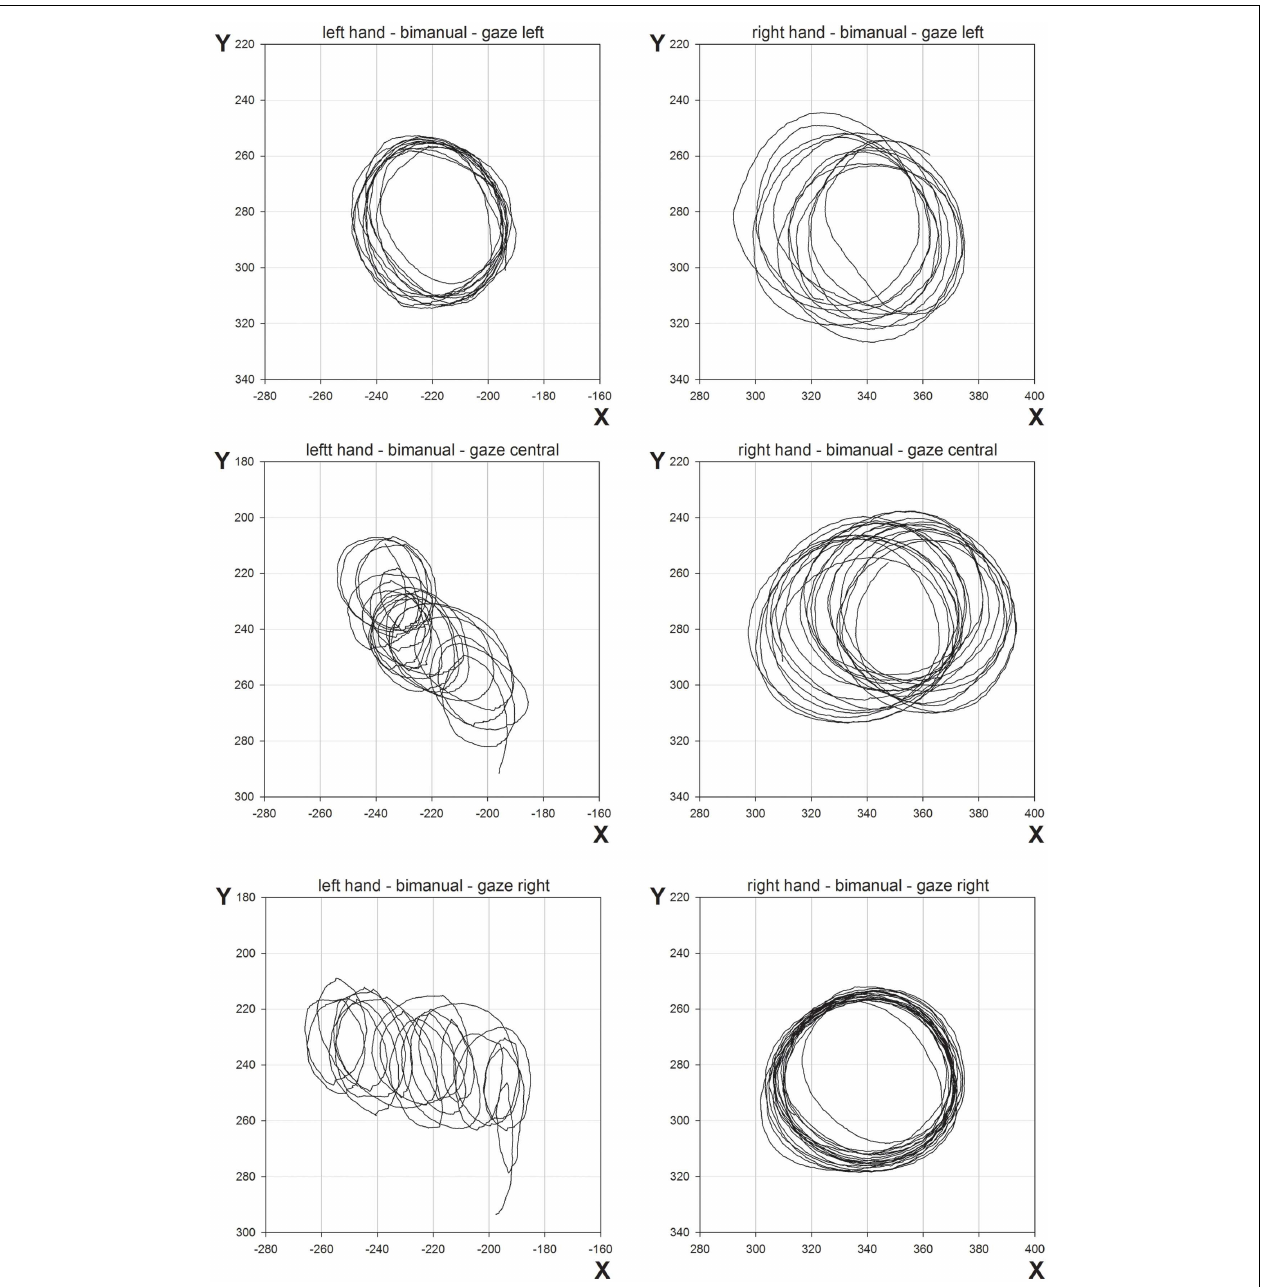
FIGURE 6 | Representative movement trajectories of bimanual conditions from Experiment 2 .